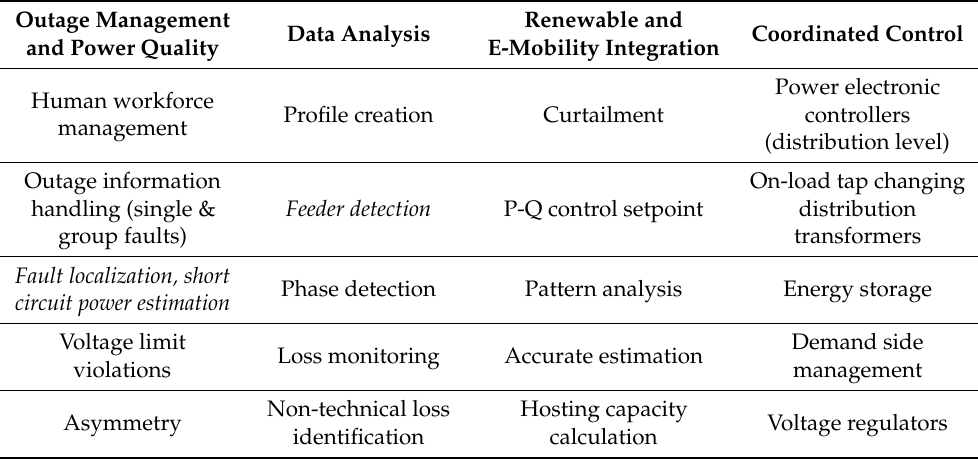
Table 1. Classification of possible DSSE utilization based on the literature